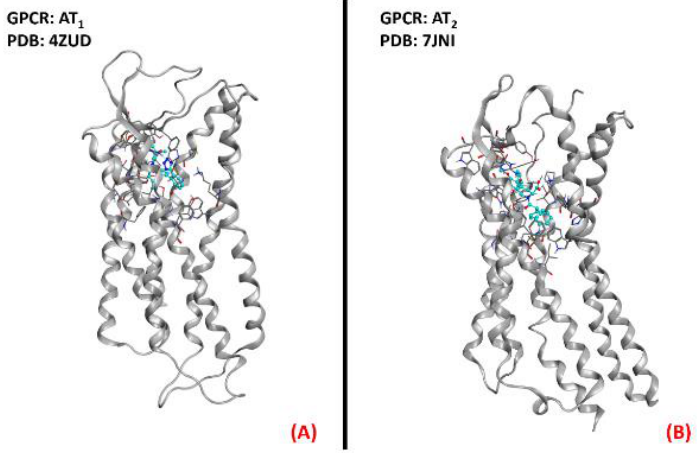
Figure 9. Representation of the three-dimensional structures of the angiotensin II receptors thatcould be considered for ALS treatment. AT 1 receptor ( A ) (sourced from the Protein Data Bank, PDB code: 4ZUD [111], method: X-ray diffraction, resolution: 2.80Å ) and AT 2 receptor ( B ) (sourced from the Protein Data Bank, PDB code: 7JNI [112], method: X-ray diffraction, resolution: 3.00 Å ).The images were created and rendered with MOE.